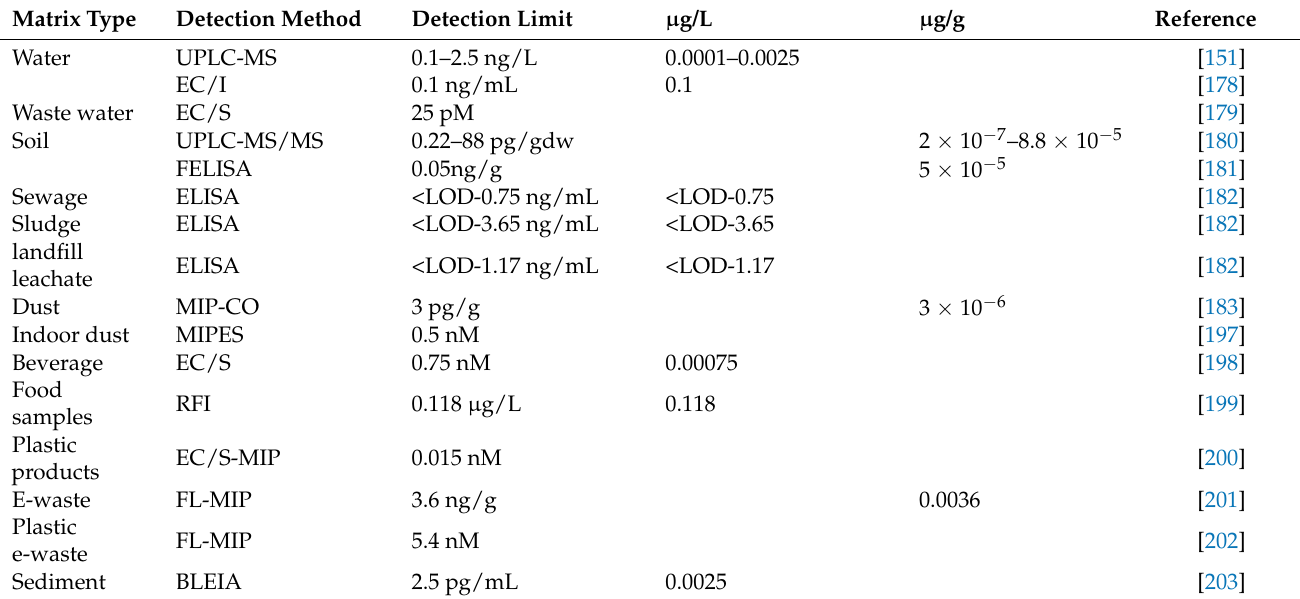
Table 4. Analytical techniques for TBBPA